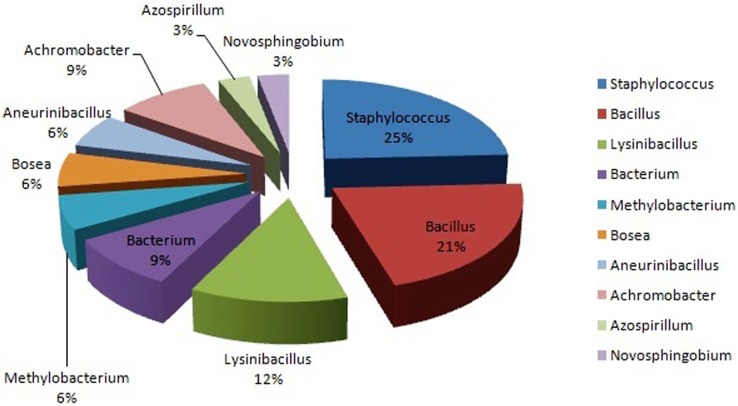
Pie chart showing the distribution of bacteria in water sediment of Tamdil Lake.